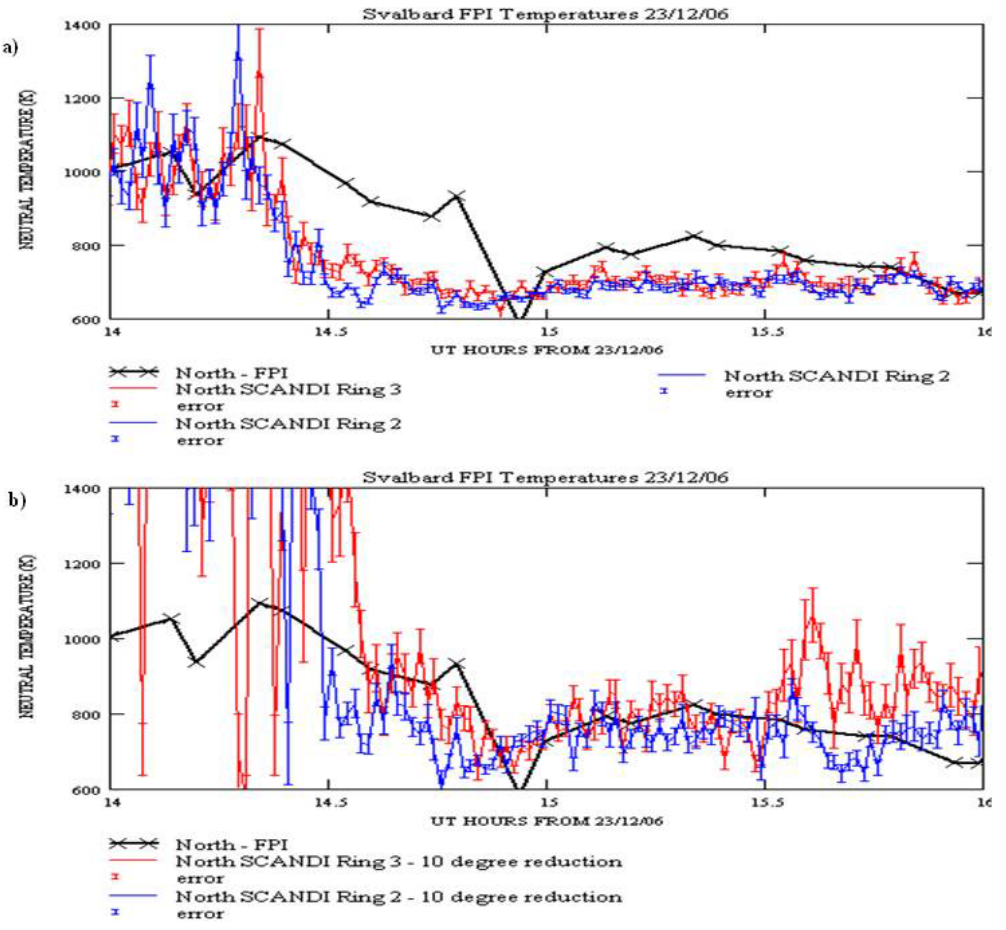
Fig. 13. Spatial structure around a scale-size of 100km is demonstrated by comparing T n averaged over ∼ 900km (90 ◦ azimuthal range) (Fig. 13a) with ∼ 100km (10 ◦ range) (Fig. 13b). The black line shows the corresponding FPI measurement of T n . Averaging the SCANDI T n over a smaller spatial range appropriate to the FPI look direction brings the two temperatures into agreement between 14.5–15.5UT. A significant temperature gradient is seen after 15.5UT between rings 2 and 3, which represents a radial distance of ∼ 300km from the centre of the SCANDI fov.